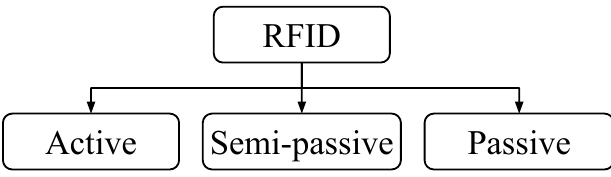
Figure 1. Taxonomy of RFID tags available on the market.